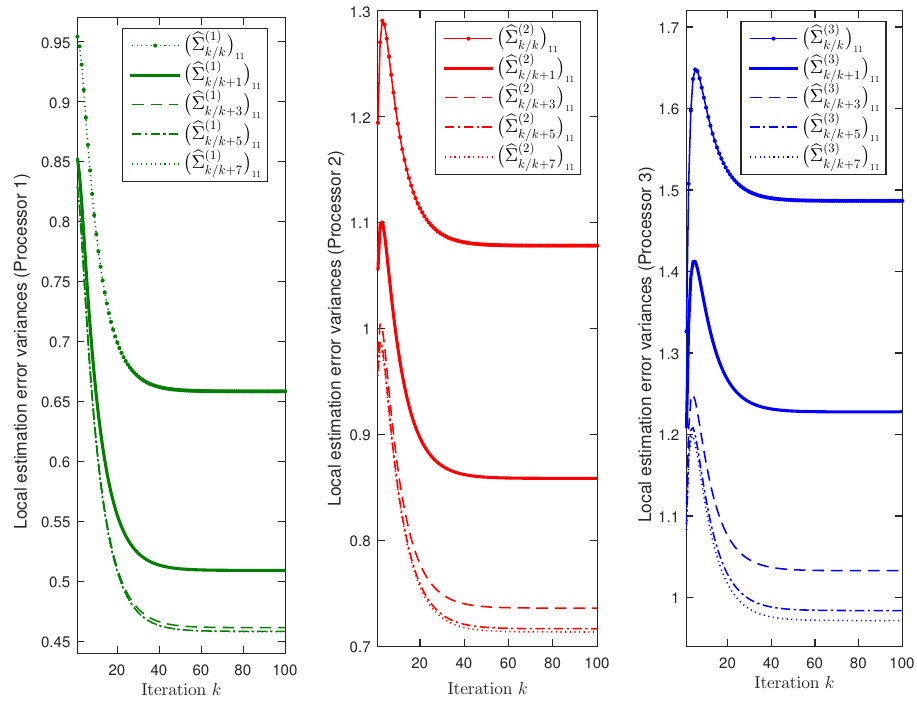
Figure 1. First signal component error variance comparison of the local filters and fixed-point smoothers.